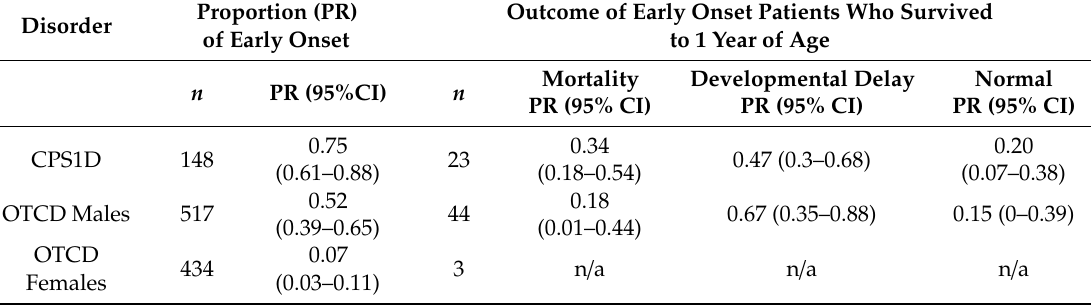
Table 1. Burden of disease for patients with early onset Urea cycle disorders (UCDs) (Adapted from Burgard 2015)